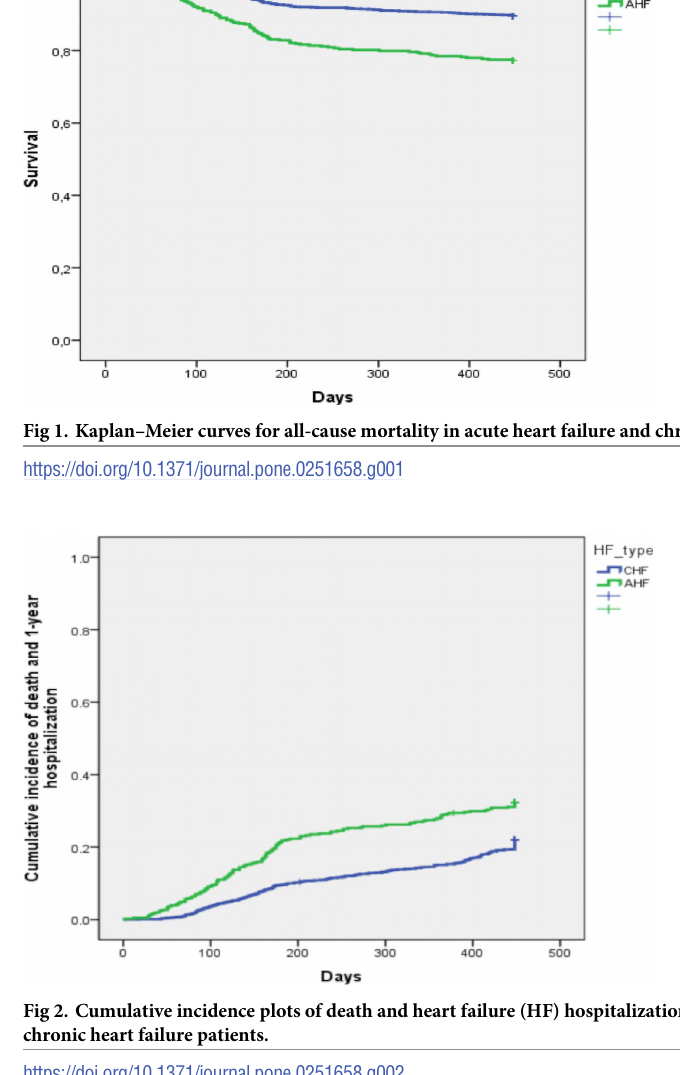
angiotensin receptor antagonists (ARBs) treatment to be independent predictors of 1-year all-